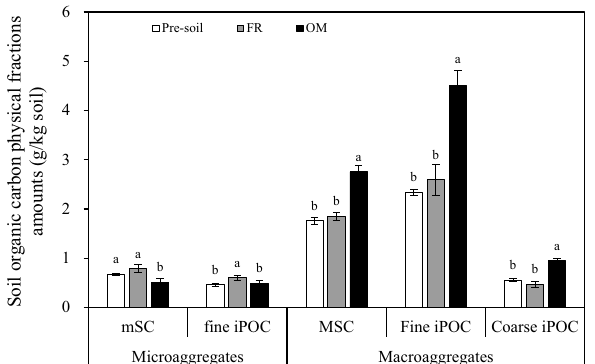
Figure 3. Soil organic carbon physical fractions amounts in different treatments. Vertical bars denote the standard error of the mean (n = 3). Different letters a, b and c indicate significant differences between treatments for the same physical fraction of soil organic carbon at p < 0.05. FR chemical fertilizer, OM organic manure, mSC mineral-incorporated organic carbon in micro-aggregates, fine iPOC fine intra-particulate organic carbon in micro-aggregates, MSC mineral-incorporated organic carbon in macro-aggregates, Fine/coarse iPOC fine/coarse intra-particulate organic carbon in macro-aggregates.